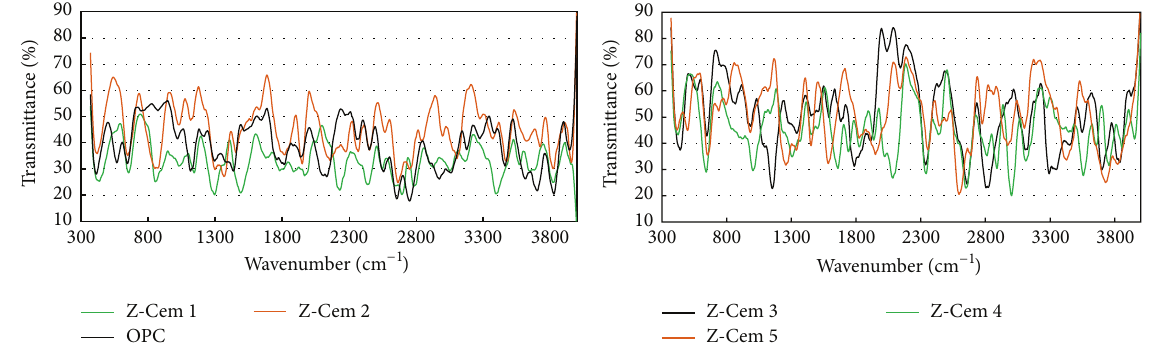
Figure 7: FTIR data of OPC and Z-Cem